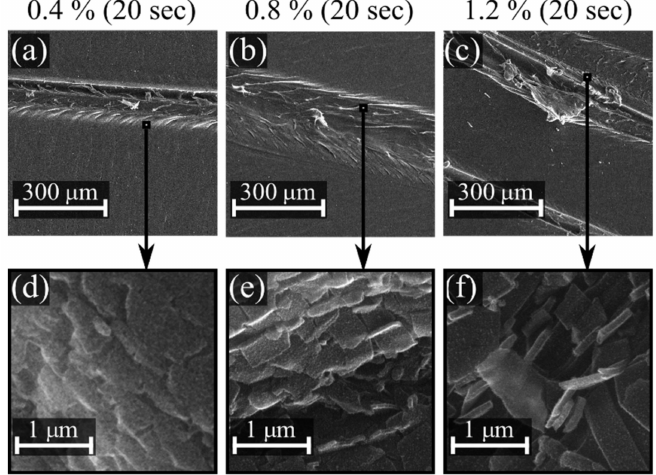
Figure 9. Surface topography of the scratched area for varied composition of processing gas, i.e., 0.4, 0.8, resp. 1.2% of P-B in nitrogen. A treatment time of 20 seconds was kept in all cases. The bottom row represents a magnified view of the surface from the area indicated on the corresponding top row